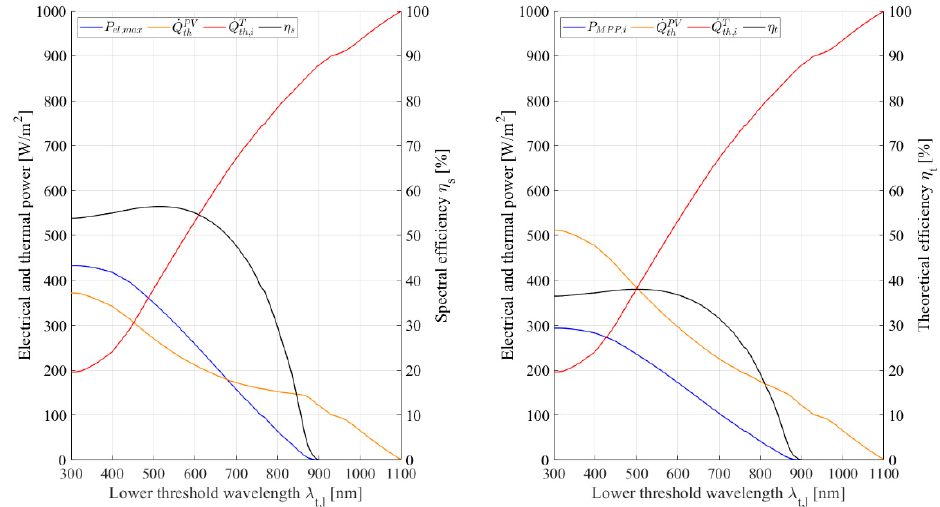
Figure 7. Key parameters of Spectral Splitting depending on lower threshold wavelength, considering spectral efficiency ( left ) and theoretical efficiency ( right ) for CdTe PV technology.